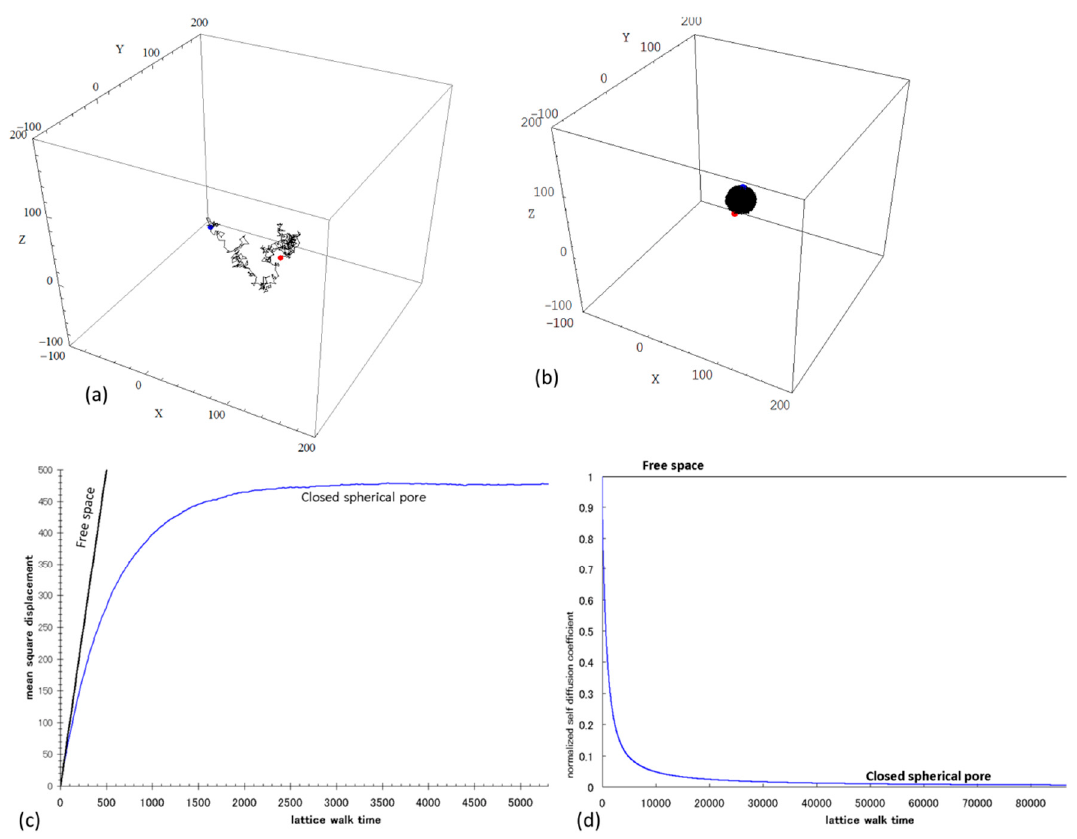
Figure 4. Sample output from the 3D Random Walk Simulation: ( a ) 3D trajectory of a walker in free space; ( b ) 3D trajectory of a walker in closed and isolated spherical pore; ( c ) plot of mean square displacement ( <r> 2 ) vs. lattice walk time; ( d ) plot of the normalized self-diffusion coefficient ( D ( t )) vs. lattice walk time.